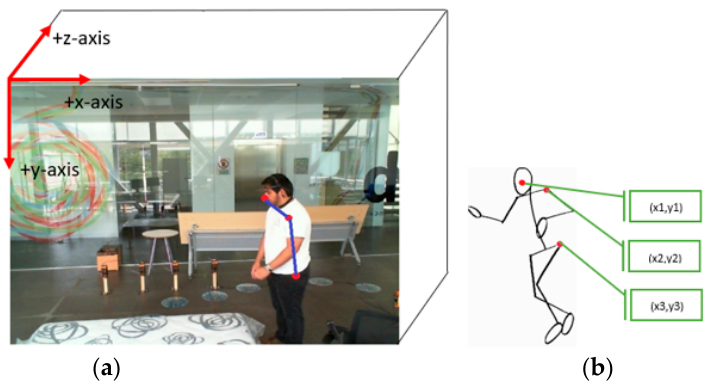
Figure 1. ( a ) A general view of the room where the experiments were conducted and the videos were recorded (Mardinez and Ponse [14]); ( b ) a simple skeleton shape indicating the points of inter- est on the subject’s